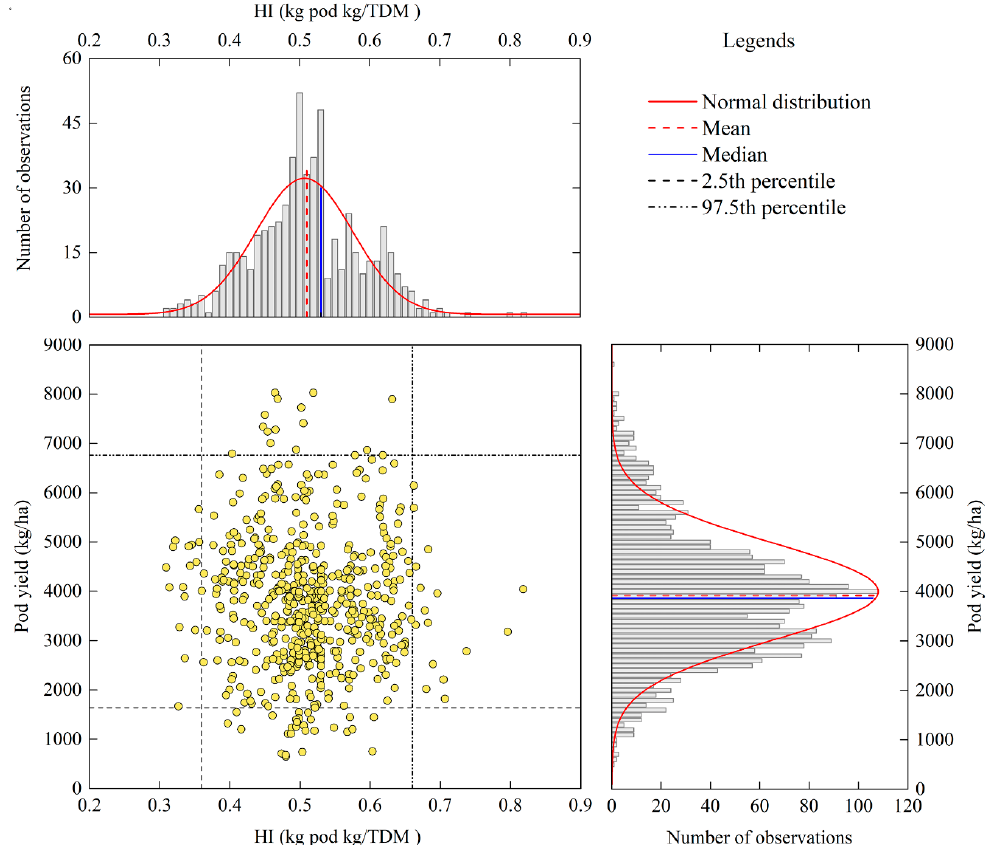
Figure 2. Distributions of the pod yields and the harvesting index of peanut crops conducted in China. Table 1. Characteristic statistics of the pod yields (10.0% moisture content) and nutrient uptake data at maturity for China’s peanut crops.